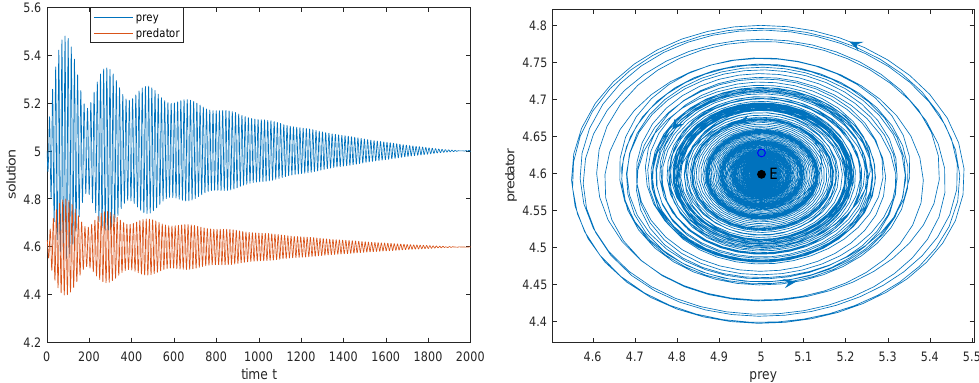
) = ( 14.6232,14.6586 ) , E in is locally asymptotically stable. Initial value: , τ + 0 1